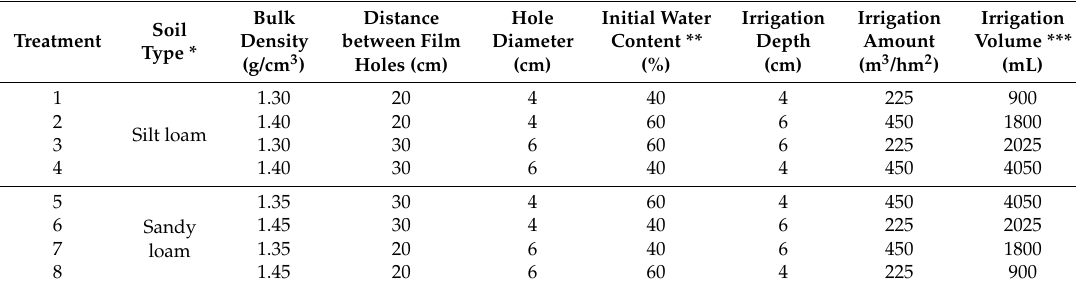
Table 1. Test scheme for film hole irrigation.